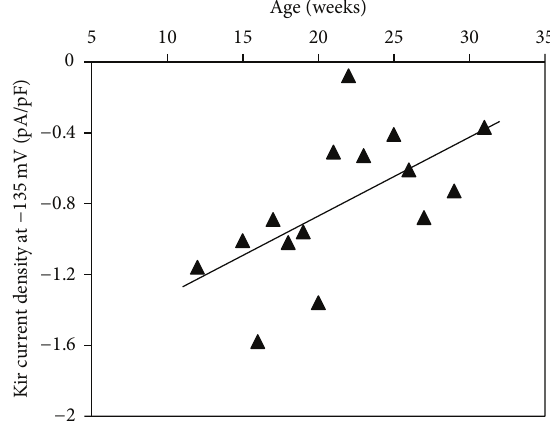
Figure 3: Age-related alteration of Kir current density (pA/pF) measured at − 135 mV in vascular smooth muscle cells of MCA of SHRsp rats ( 𝑛 = 15 ). Solid line represents first-order linear regression (correlation coefficient 𝑟 = 0.587, 𝑃 < 0.05